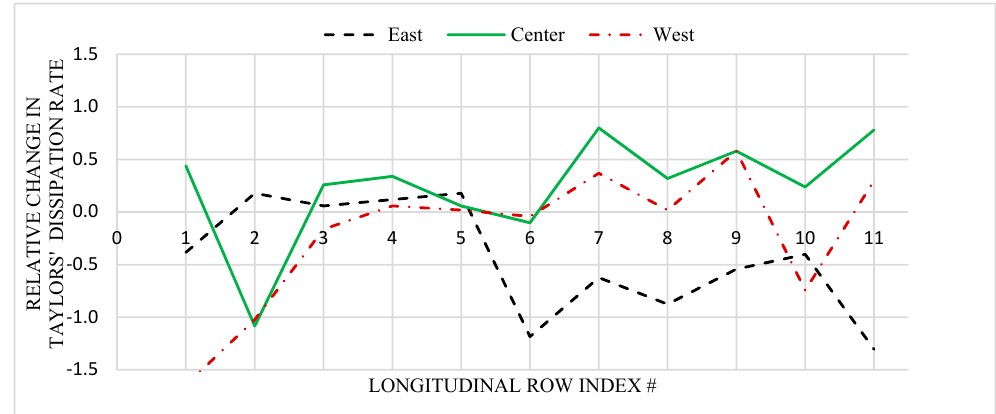
sides of the cabin. This indicated that the velocities and k were lower in these regions.